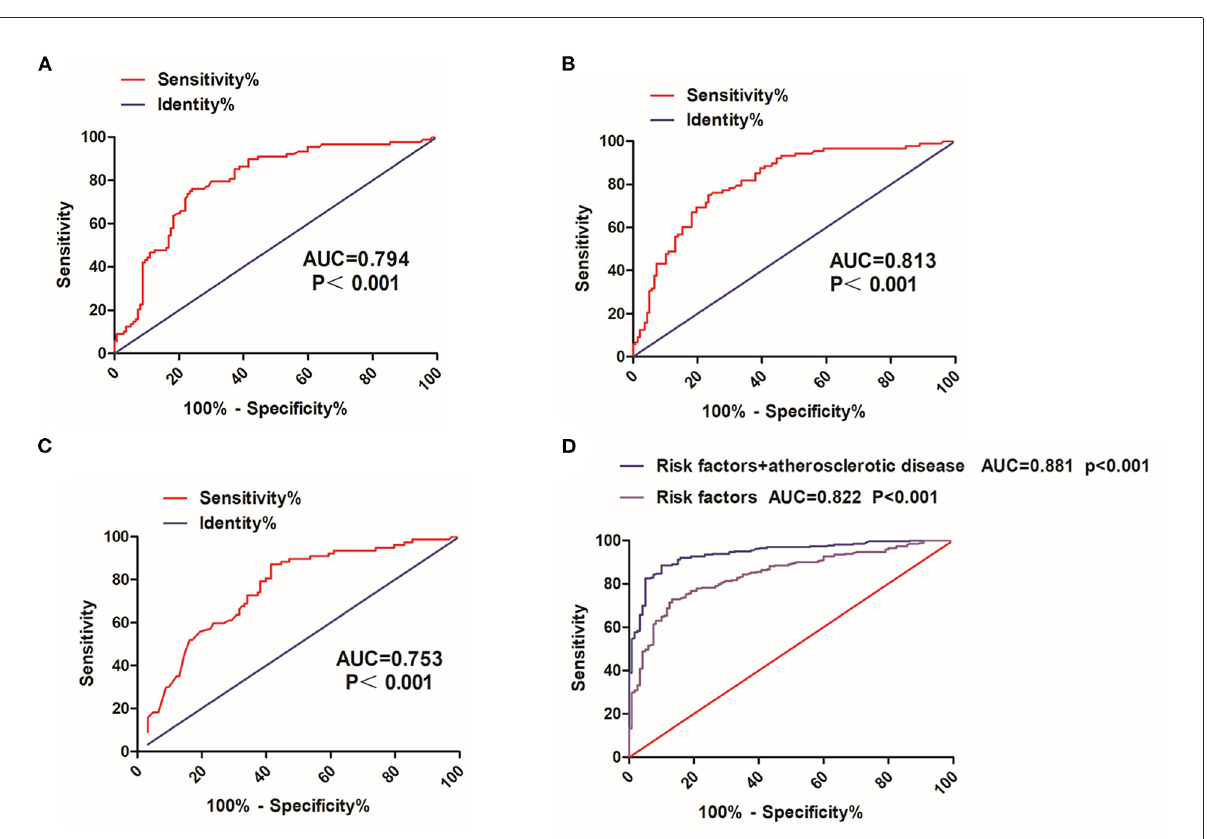
FIGURE4 ROC curve analysis of FT3, FT4, and TSH. (A) FT3, free triiodothyronine, (B) FT4, free thyroxine, and (C) TSH, thyrotropin. (D) Risk factor (FT3, FT4, and TSH) and atherosclerotic disease ROC curve, receive operating characteristic curve; AUC, the area under the ROC